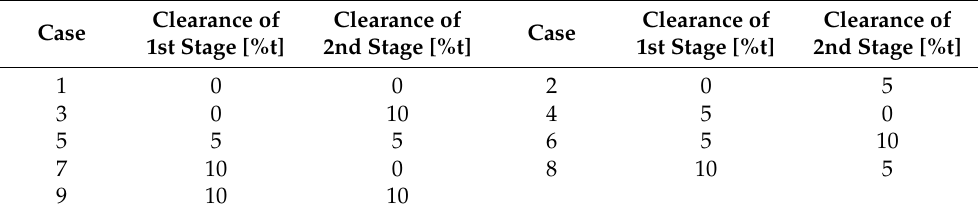
Table 3. Cases of FE simulation.